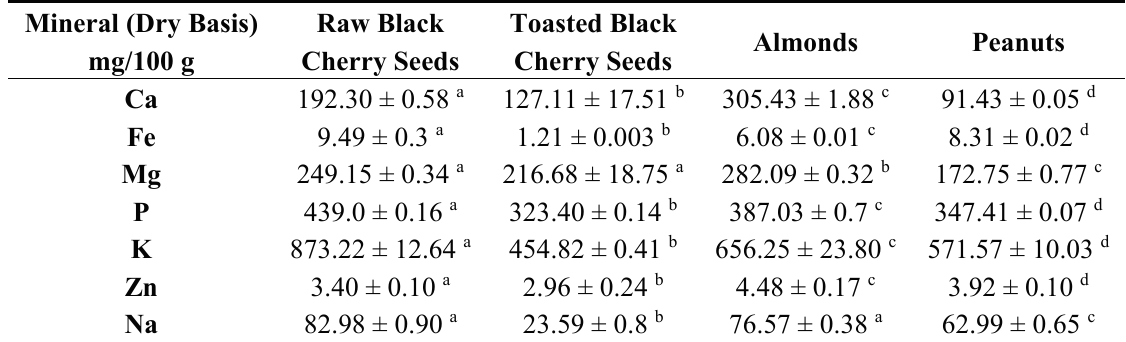
Table 2. Mineral composition of raw and toasted black cherry seeds, almond and peanut. Mineral (Dry Basis) mg/100